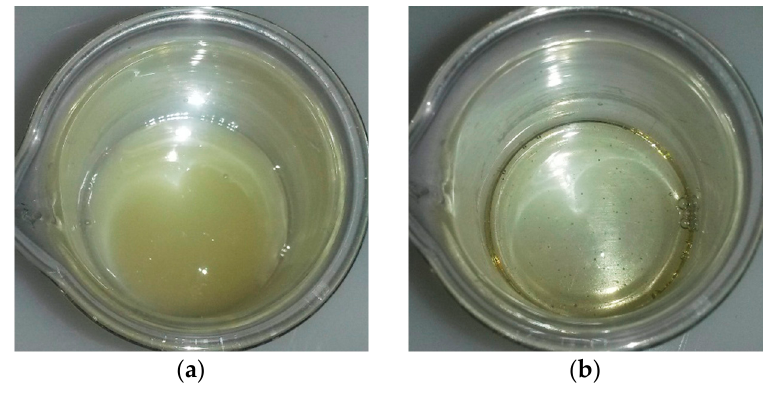
Figure 2. Picture of TETM/DDS mixed at ( a ) 100 °C and ( b ) 180 °C.